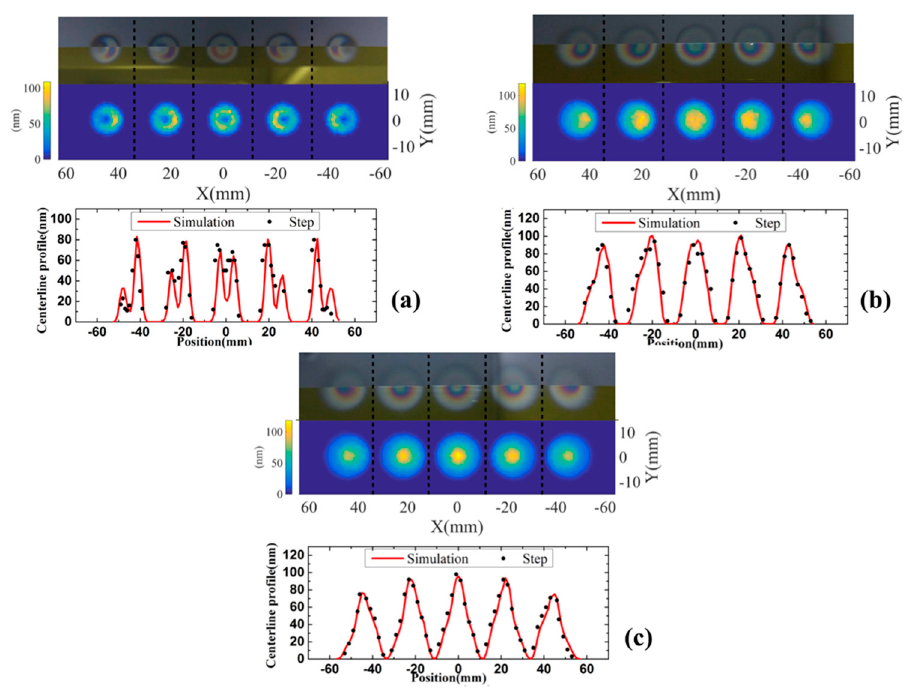
Figure 8. Comparison of different hole sizes on the masks. ( a ) Hole diameter of 3 mm, d 1 = 62 mm, d 2 = 8 mm. ( b ) Hole diameter of 6 mm, d 1 = 62 mm, d 2 = 8 mm. ( c ) Hole diameter of 10 mm, d 1 = 62 mm, d 2 = 8 mm.